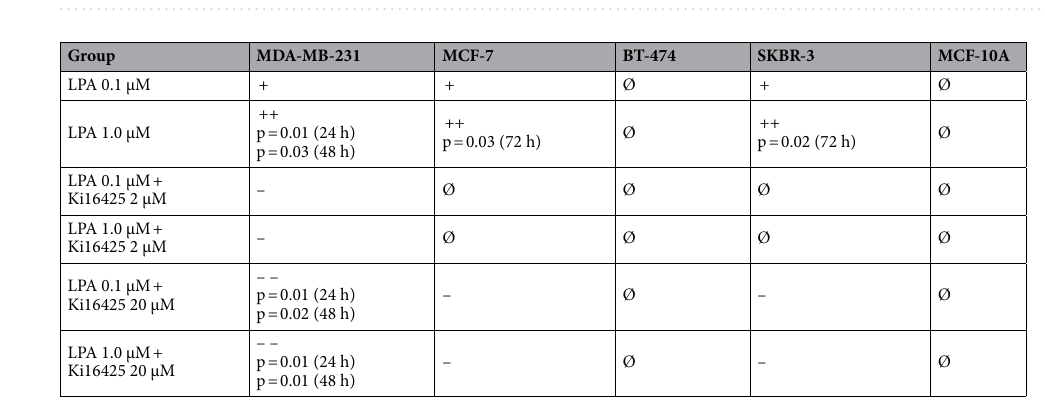
Figure 2. Migration assay. Effect of lysophosphatidic acid (LPA) 18:1 and the LPA receptor 1, 3 (and 2) inhibitor Ki16425 on migration after 24 h, 48 h, and 72 h of different human breast cancer cell lines (control 24 h = 1). (A–C) Data points show the ratio of migrated cells (y-axis) with the addition of varying concentrations of LPA compared to the control group for several time points (x-axis). (D–F) Data points show the ratio of migrated cells (y-axis) with the addition of 1.0 µM LPA and Ki16425 in varying concentrations as well as the control group for several time points (x-axis). n = 3 replicate experiments, values are presented as mean ± SD. *: p ≤ 0.05 compared to the control group; #: p ≤ 0.05 compared to 1.0 μM LPA (Kruskal–Wallis test and post-hoc Dunn’s test).